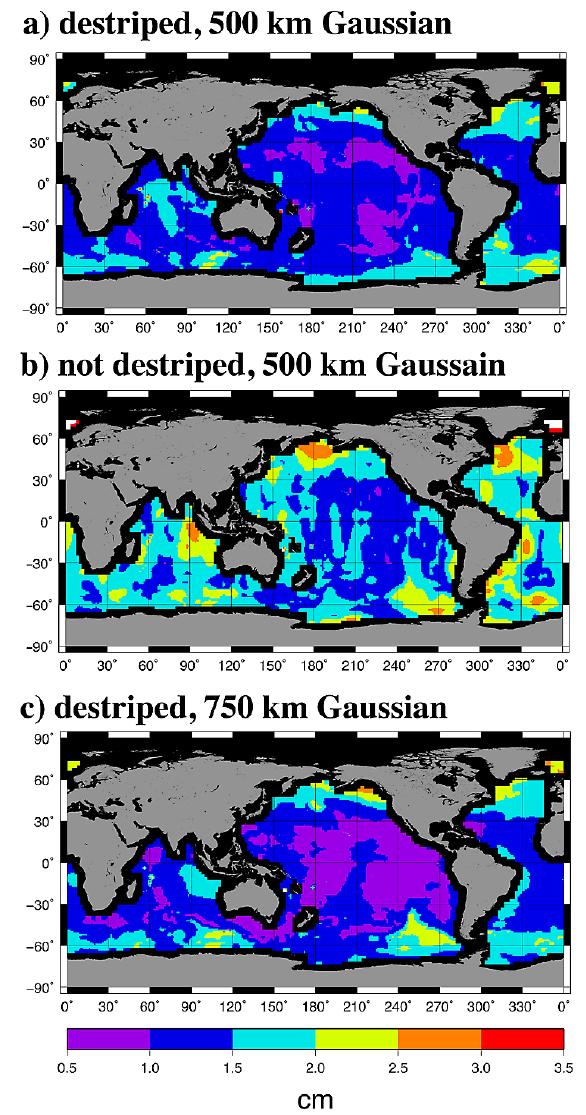
Fig. 7. Standard deviation of differences between unsmoothed OBP from JPL ECCO and CSR RL05 mapped OBP for (a) destriping and 500km Gaussian, (b) no destriping and 500km Gaussian, and (c) destriped and 750km Gaussian.